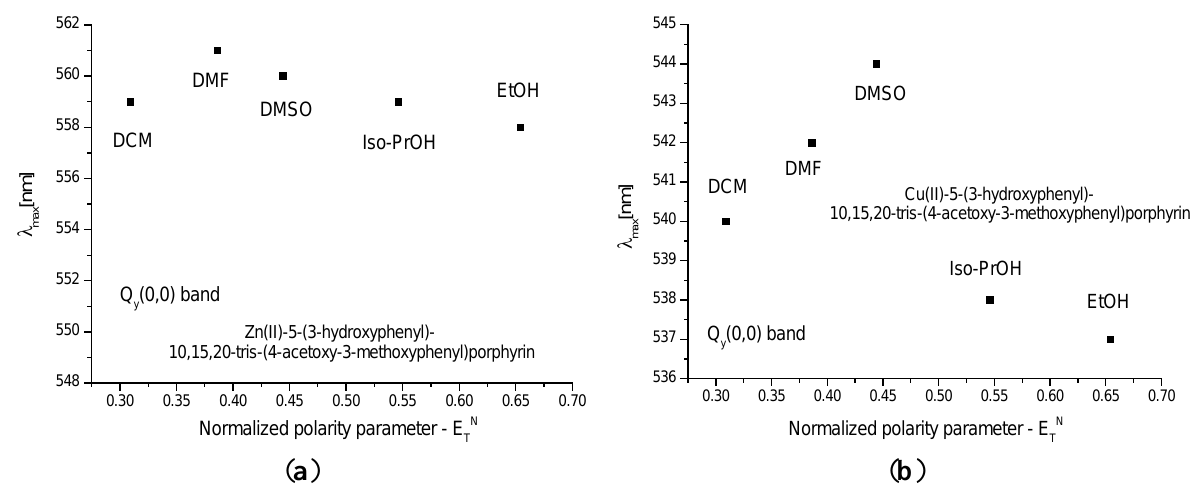
Figure 3. Reichardt’s normalized polarity parameter vs. wavelengths maxima of the Soret bands for ( a ) P1 and ( b ) P2 .